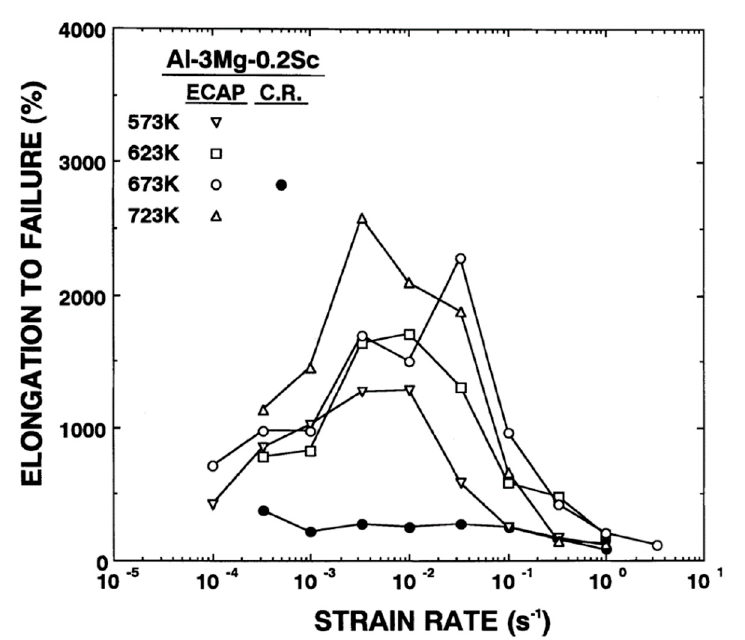
Figure 6. Elongation to failure versus strain rate for an Al–3Mg l–0.2Sc alloy tested after processing by ECAP or cold rolling (CR) [33].